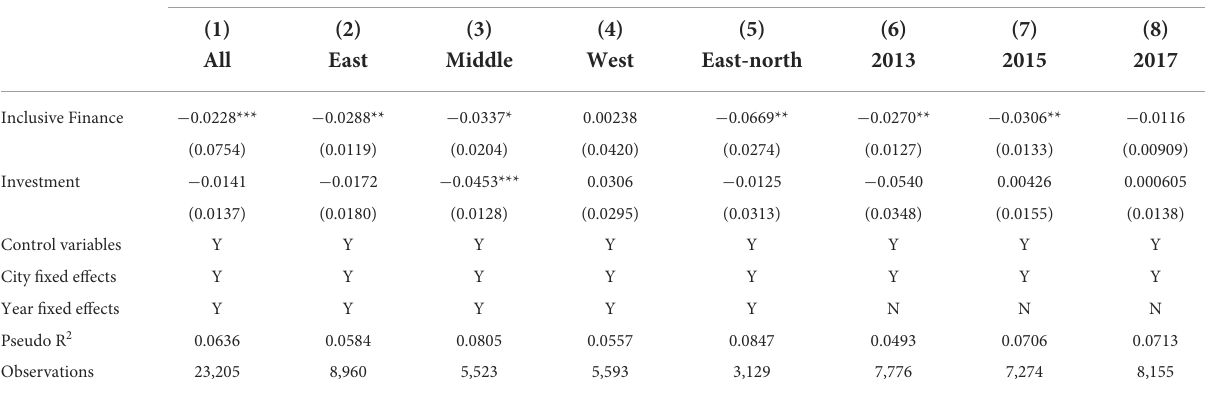
TABLE 6 Regression results for the effect of investment on